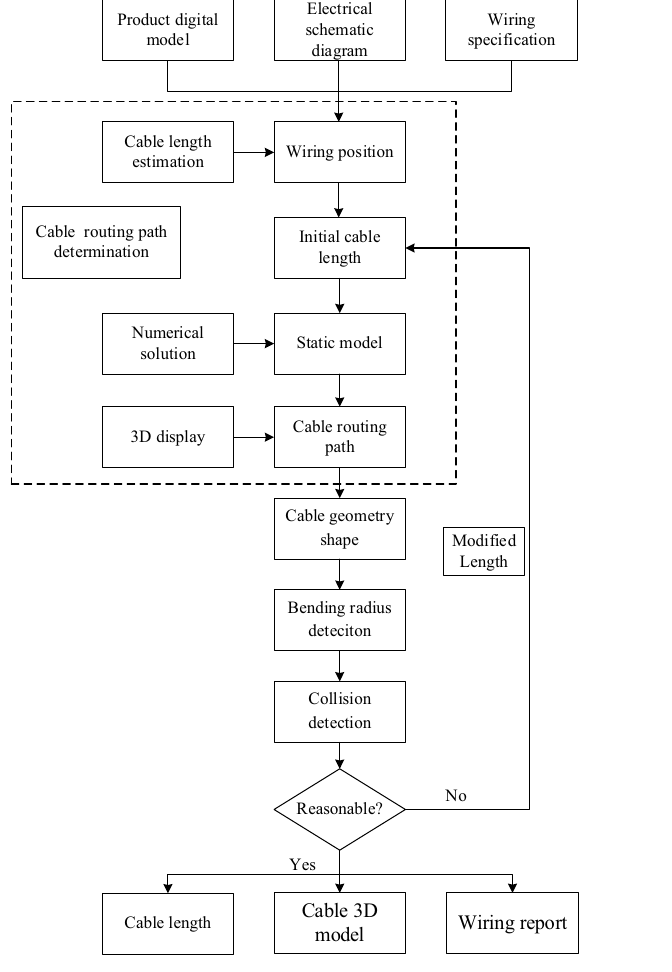
Figure 10. Development process of the cable routing module.